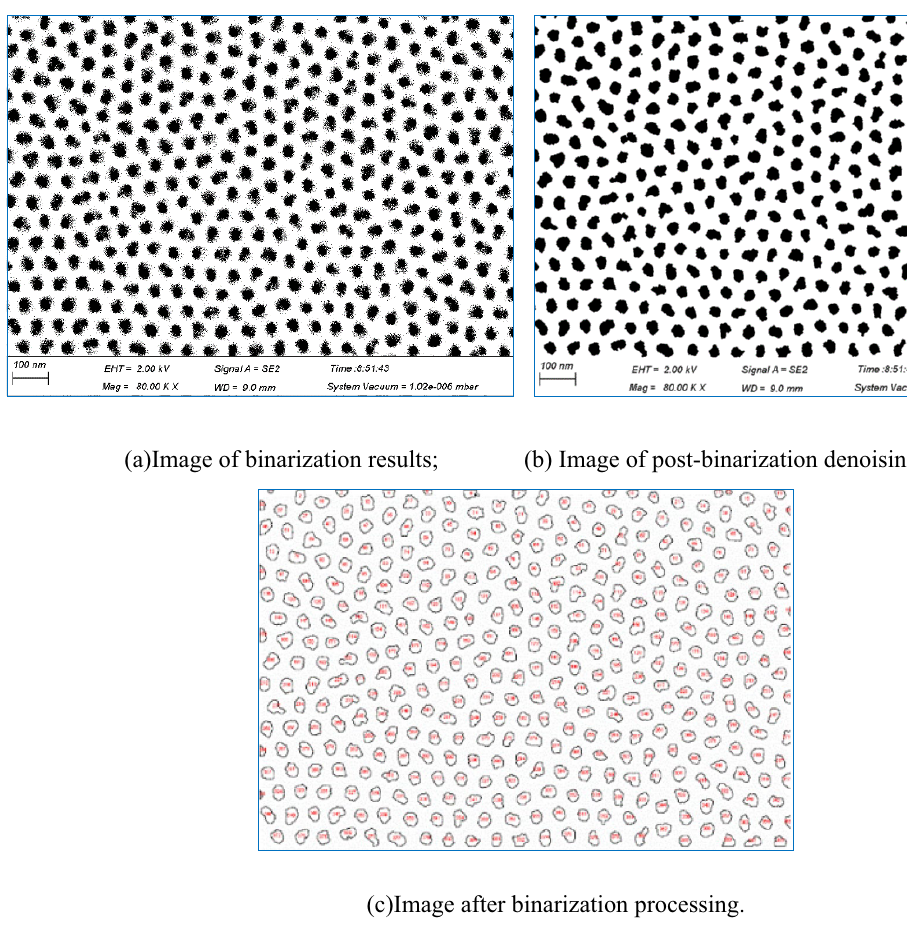
Fig. 3 Binarization processing of the